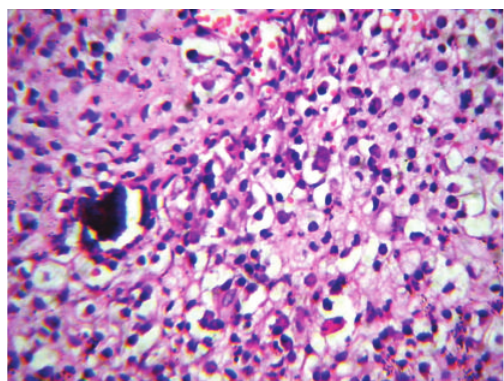
Figure 2: Sheets of foamy histiocytes admixed with lymphocytes and plasma cells. A necrotic bone fragment is also seen (H and E,